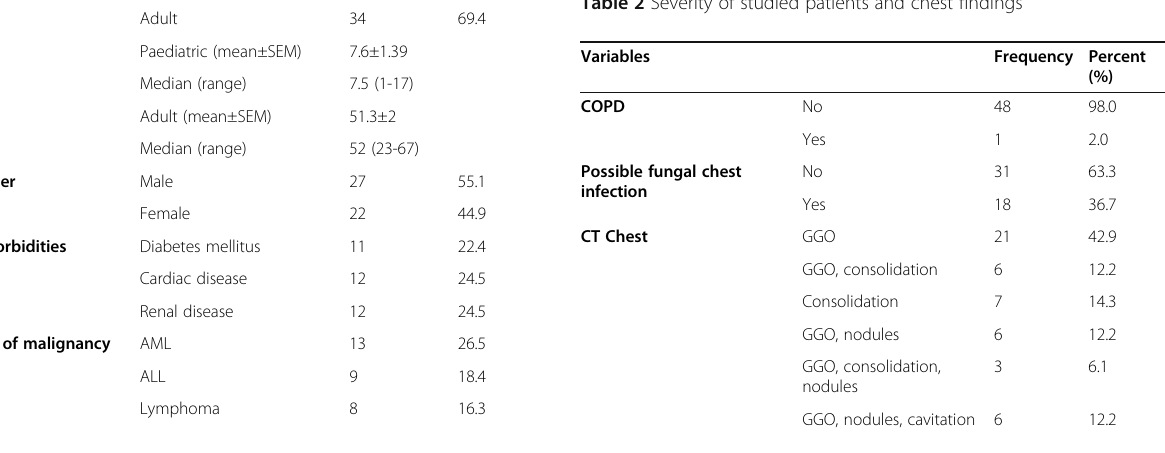
Table 2 Severity of studied patients and chest